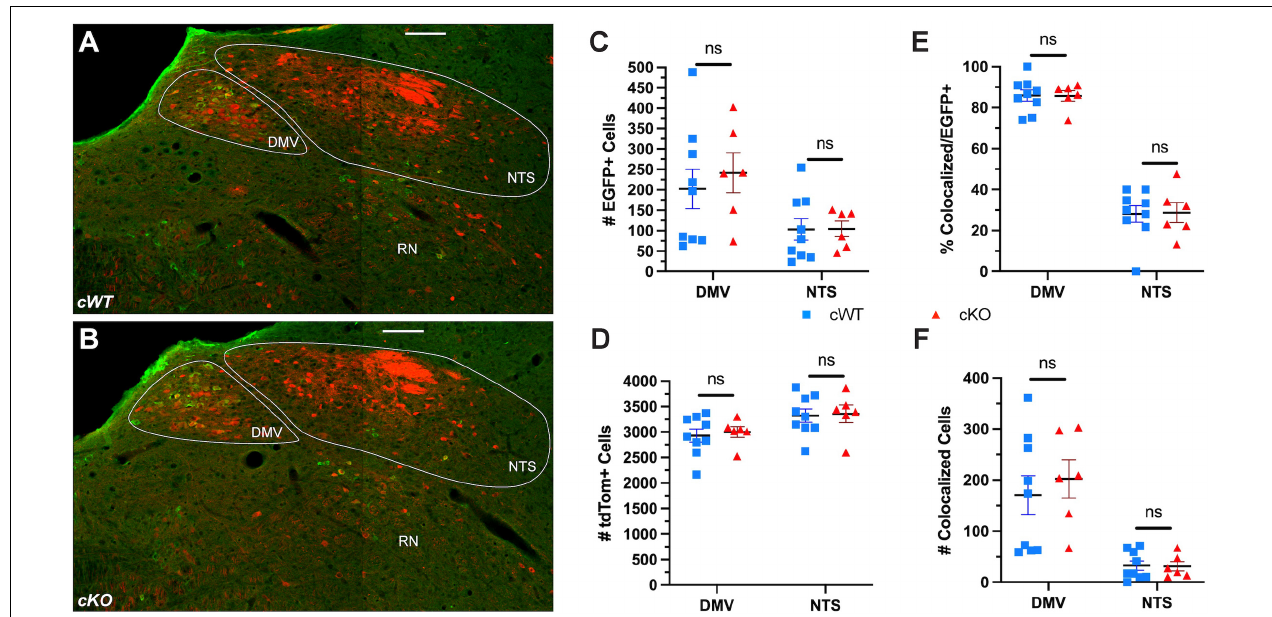
FIGURE 6 | No difference in the number of neurons in the NTS or DMV is observed following conditional deletion of MET. (A,B) Representative images of the DMV, NTS, and reticular nucleus (RN) from cWT and cKO mice on P60. (C) EGFP + cell counts in the DMV and NTS from cWT and cKO mice on P60. n = 9 cWT, 6 cKO. No significant difference was found between genotypes using a non-parametric Mann-Whitney test. (D) tdTom + cell counts in the DMV and NTS from cWT and cKO mice on P60. n = 9 cWT, 6 cKO. No significant difference was found between genotypes using a non-parametric Mann-Whitney test. (E) Percentage of EGFP + cells co-expressing tdTom in the DMV and NTS from cWT and cKO mice on P60. No significant difference was found between genotypes using a non-parametric Mann-Whitney test. (F) Number of EGFP + cells co-expressing tdTom in the DMV and NTS from cWT and cKO mice on P60. No significant difference was found between genotypes using a non-parametric Mann-Whitney test. All scale bars = 100 µ m. The brightness and contrast of each channel was adjusted separately for visualization